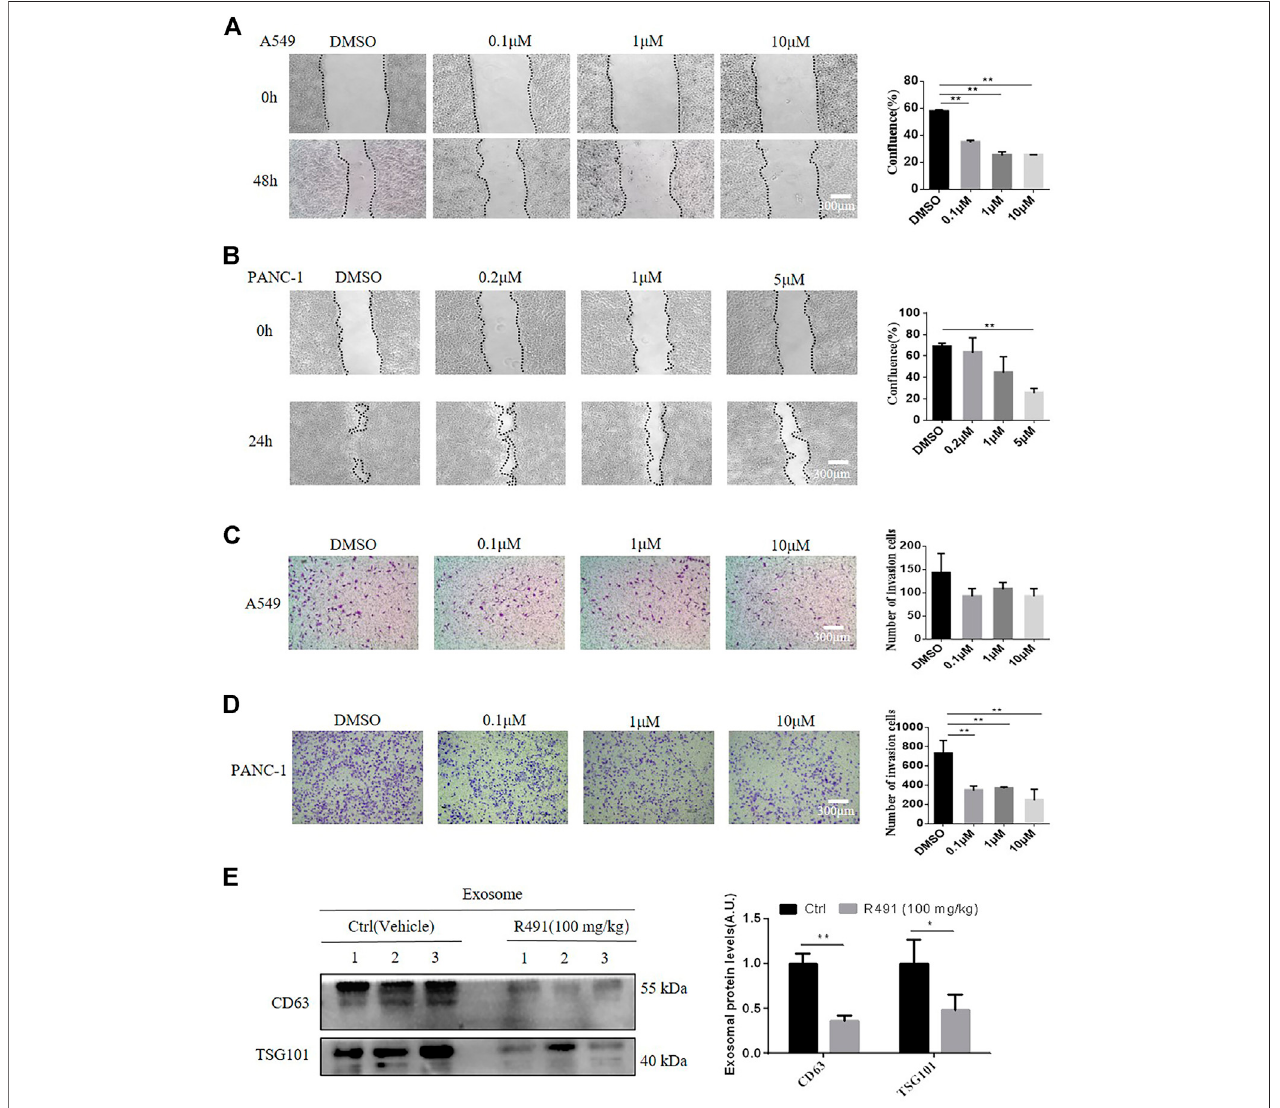
FIGURE 6 | The vimentin-binding compound R491 signi fi cantly inhibits cancer cell migration and invasion. (A, B) The wound assay, showing the migration of the A549 and PANC-1 cells before and after treated with R491 at different concentrations for 48 h (A) or 24 h (B) duration (left), and the quanti fi cation of con fl uence (right). Scalebars:300 µm. (C,D) Transwellinvasionassay,showingthemigrationof (C) A549or (D) PANC-1cellstreatedwithDMSOorwithR491atdifferentconcentrations for24 h(left),andquanti fi cationofthemigratedcells(right). (E) WesternblotanalysisofexosomalmarkerCD63andTSG101fromsEVspuri fi edbysucrosedensity gradient centrifugation from plasma of mice after the administration of R491 (100 mg/kg, i.g., once daily, n (cid:2) 3) or vehicle (n (cid:2) 3) for 14 days. Quanti fi cation of exosomal proteins in three independent Western blots. Scale bars: 300 µm. The data are expressed as mean ± SEM (n (cid:2) 3). * p < 0.05, ** p < 0.01 as determined by two-tailed Student ’ s